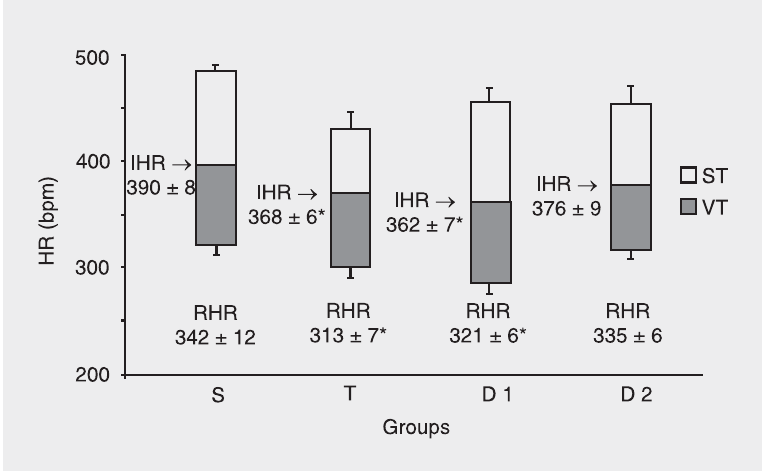
Figure 1. Vagal (VT) and sympathetic (ST) tone and resting heart rate (RHR) in sedentary (S) and trained (T) rats, and in rats detrained for 1 week (D1) and for 2 weeks (D2; see Material and Methods for calculation). IHR = intrinsic heart rate. Data are reported as means ± SEM. *P ≤ 0.05 vs S rats (one-way ANOVA). Note that exercise training induced resting bradycardia, which was paralleled by a reduction in IHR. Of interest, the partial reversal of RHR to pre-exercise training levels was associated with an increased